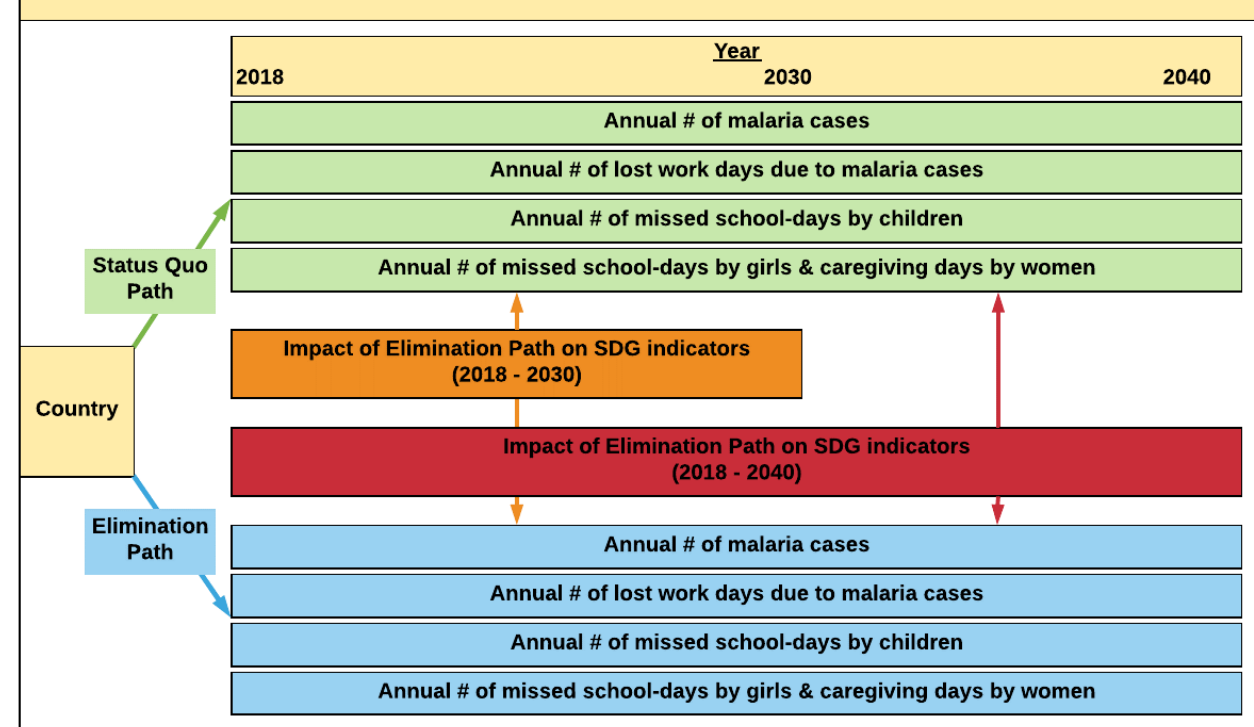
The first time period, from 2018 to 2030, corresponds to the target year of 2030 for achieving the SDGs; 2030 is also the final year of the “Global Technical Strategy for Malaria” (World Health Organization, 2015). This strategy has estab- lished a goal of suppressing the incidence of malaria cases by 90 percent by 2030 relative to 2015 levels (World Health Organization, 2015). The second period, from 2018 to 2040,